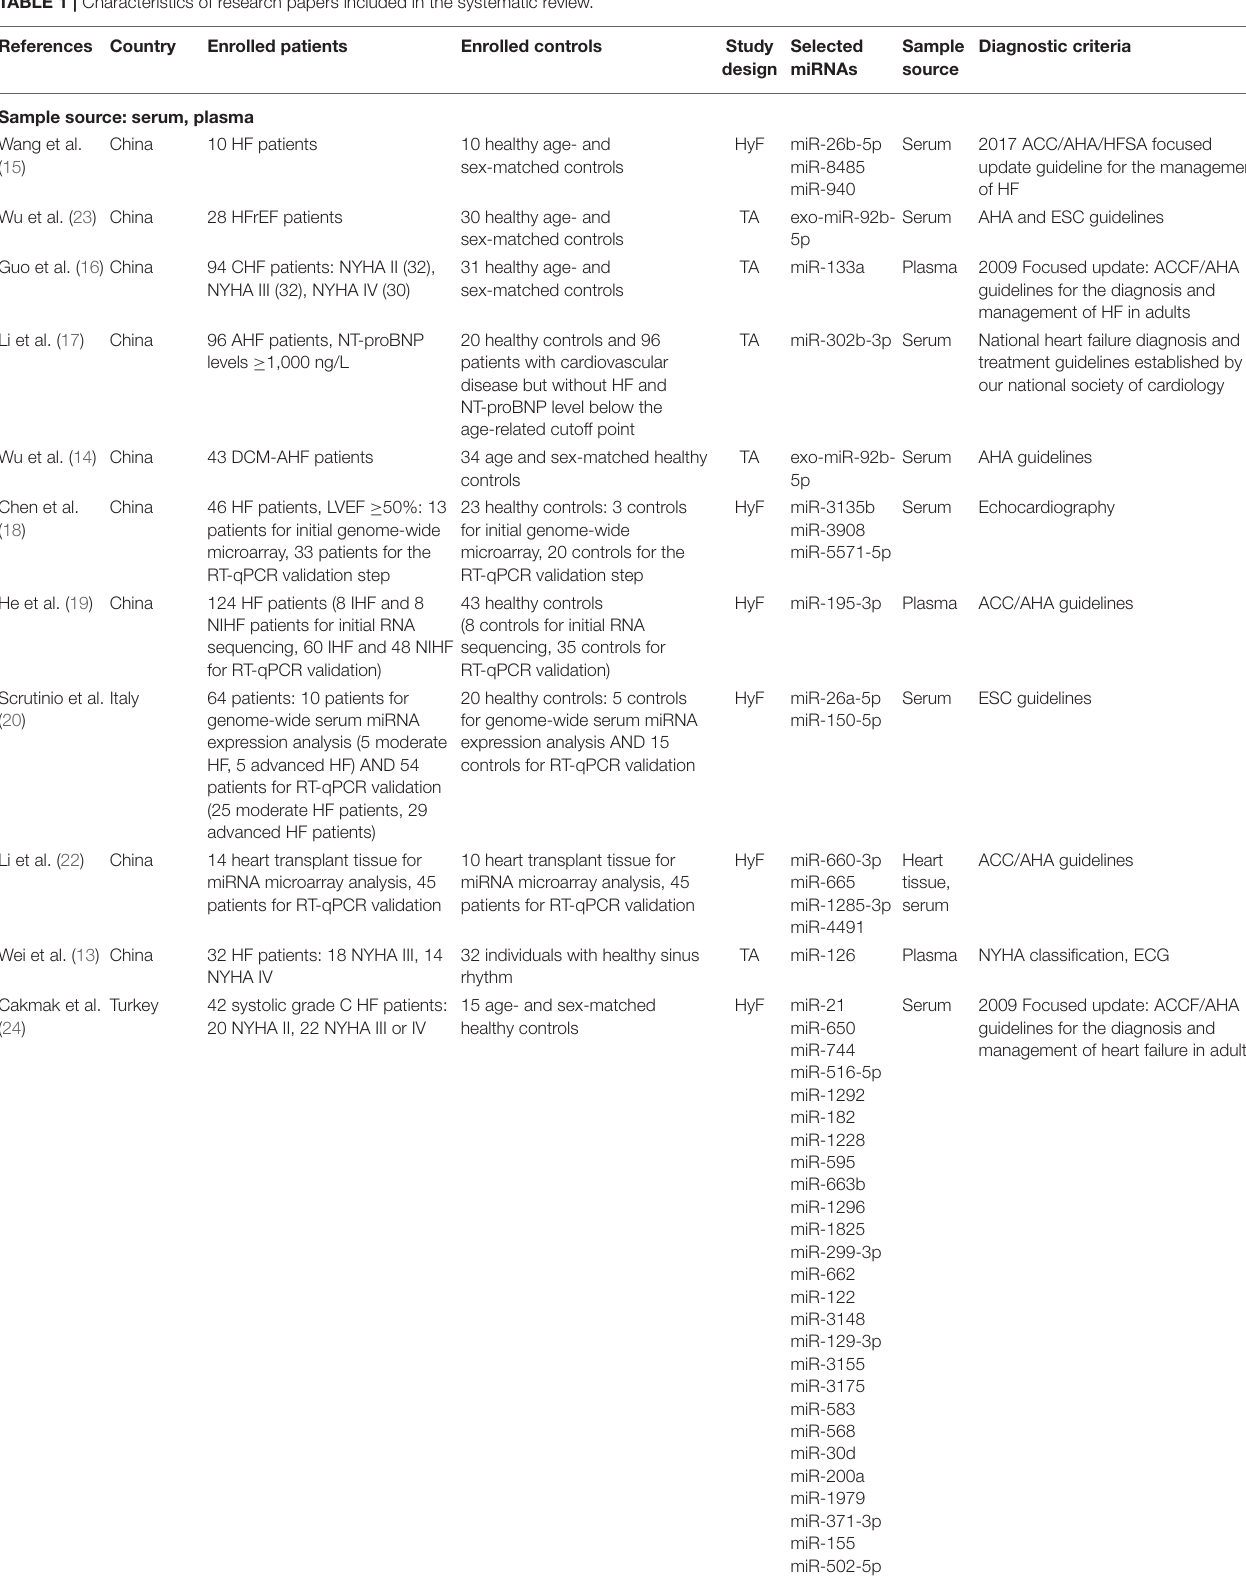
TABLE 1 | Characteristics of research papers included in the systematic